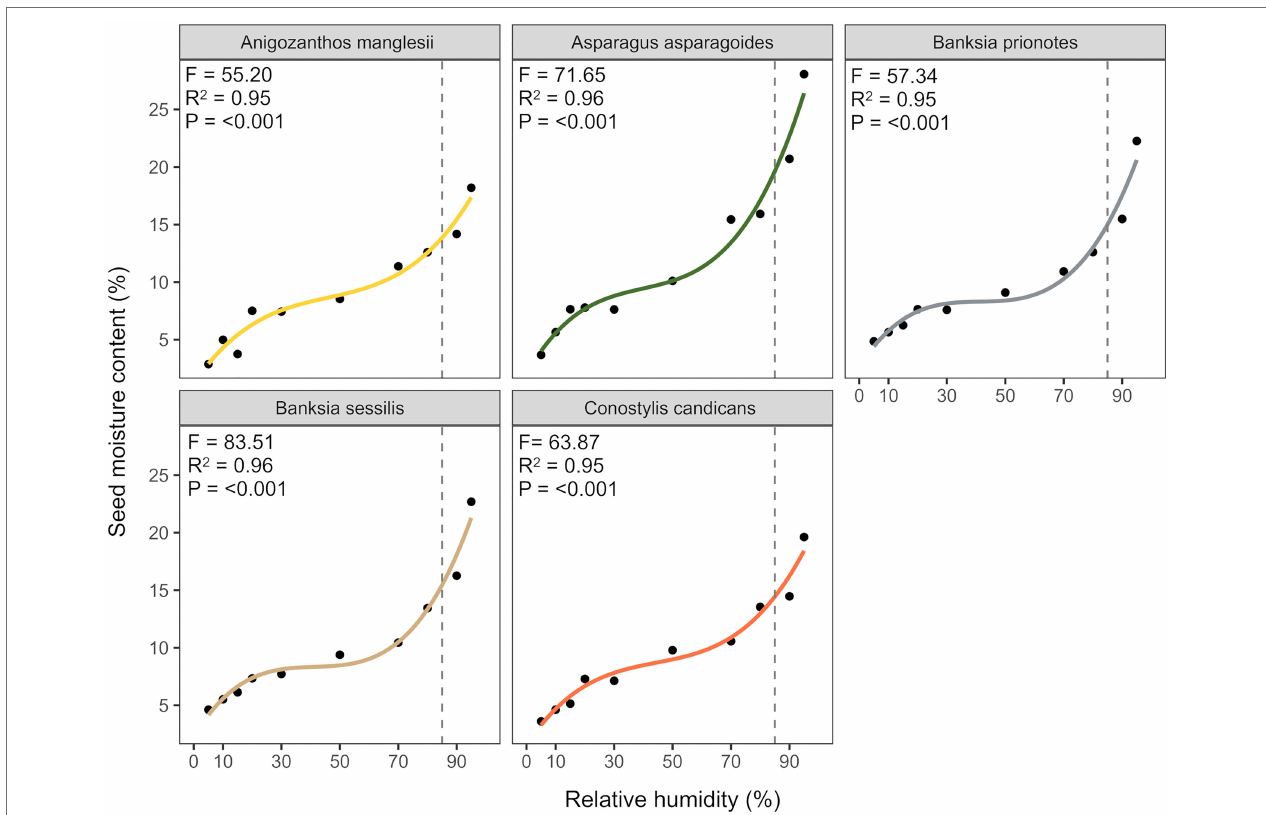
FIGURE 1 | Fitted isotherms of the five study species using cubic polynomial models describing the relationship between seed moisture content and relative humidity of seeds, at 20 °